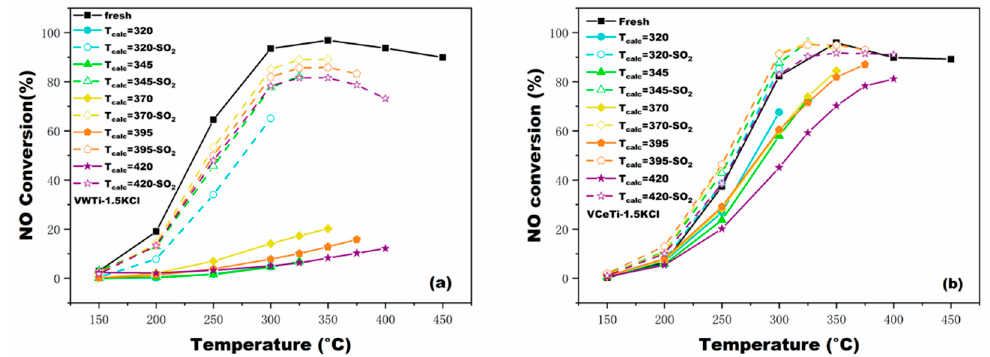
Figure 5. Regeneration effects of: ( a ) poisoned V 2 O 5 -WO 3 /TiO 2 catalyst; and ( b ) poisoned V 2 O 5 -Ce(SO 4 ) 2 /TiO 2 catalyst at n(K)/n(V) = 1.5 through SO 2 -treatment. The poisoned catalysts were